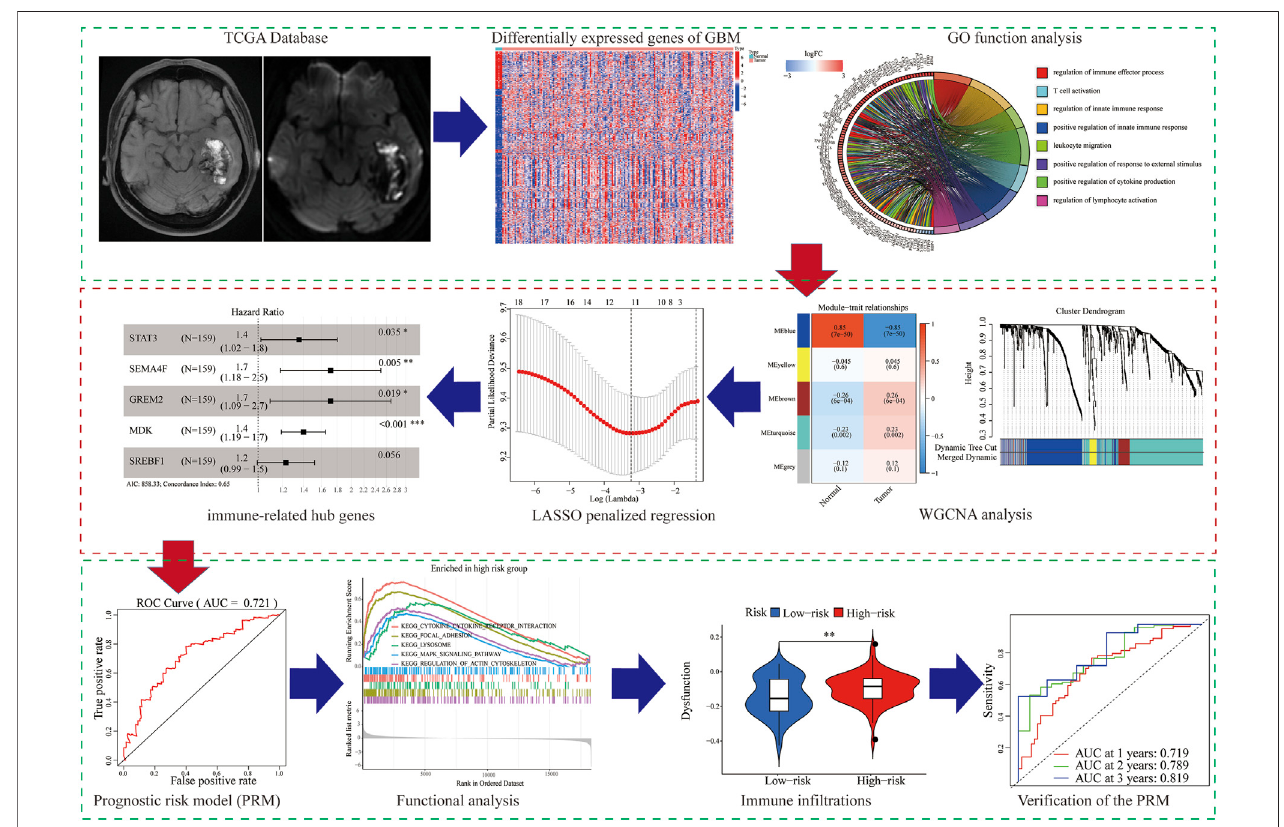
FIGURE 1 | Flowchart of the work fl ow of the immune-related